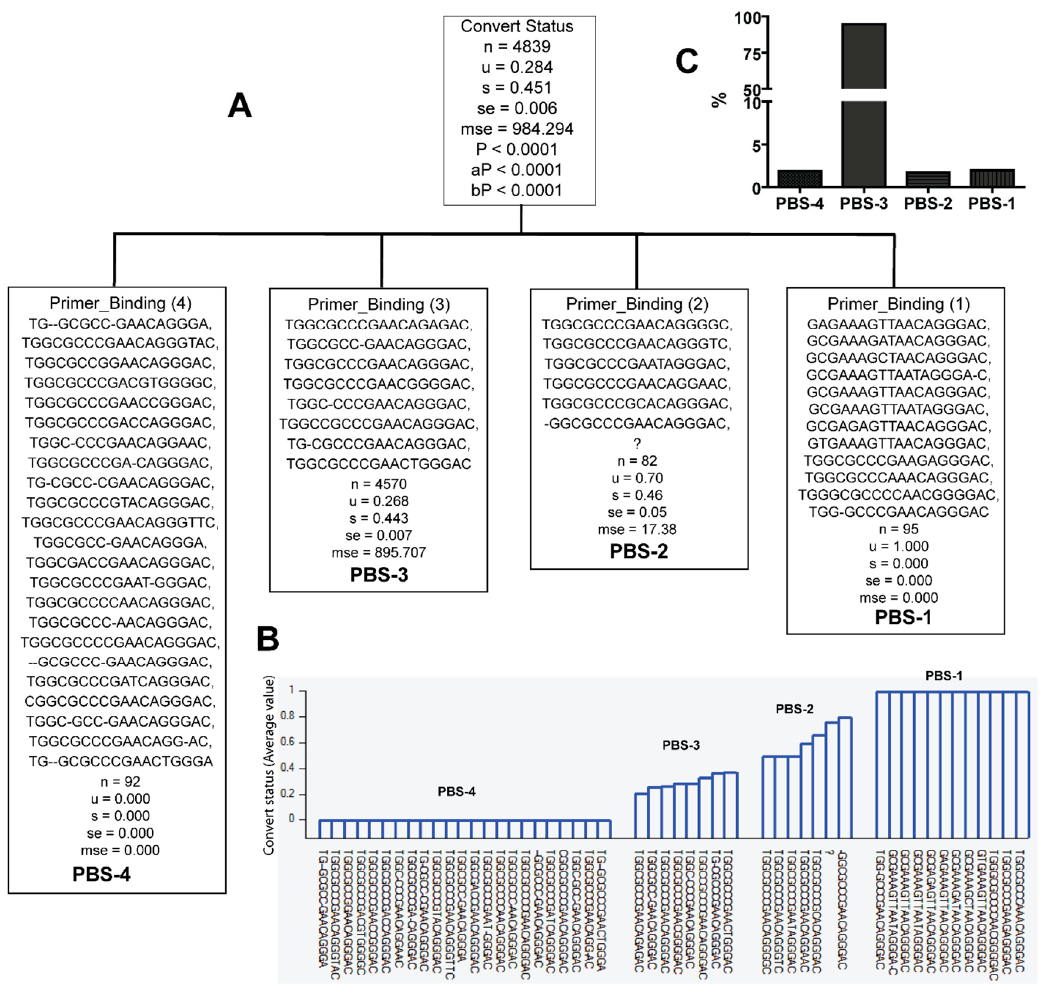
Figure 3. Classification of primer binding sequence (PBS) variants according to whether they were identified from late seroconverters ( u = 1) or early seroconverters ( u = 0). Note: question mark denotes lack of sequence. u— mean value; s—standard deviation; se—standard error; mse—mean square error; p—p value; aP—adjusted p value; bP—Bonferroni corrected p value. ( A ) Classification tree; ( B ) PS variants and their distribution with seroconversion status; ( C ) PBS variants frequencies.